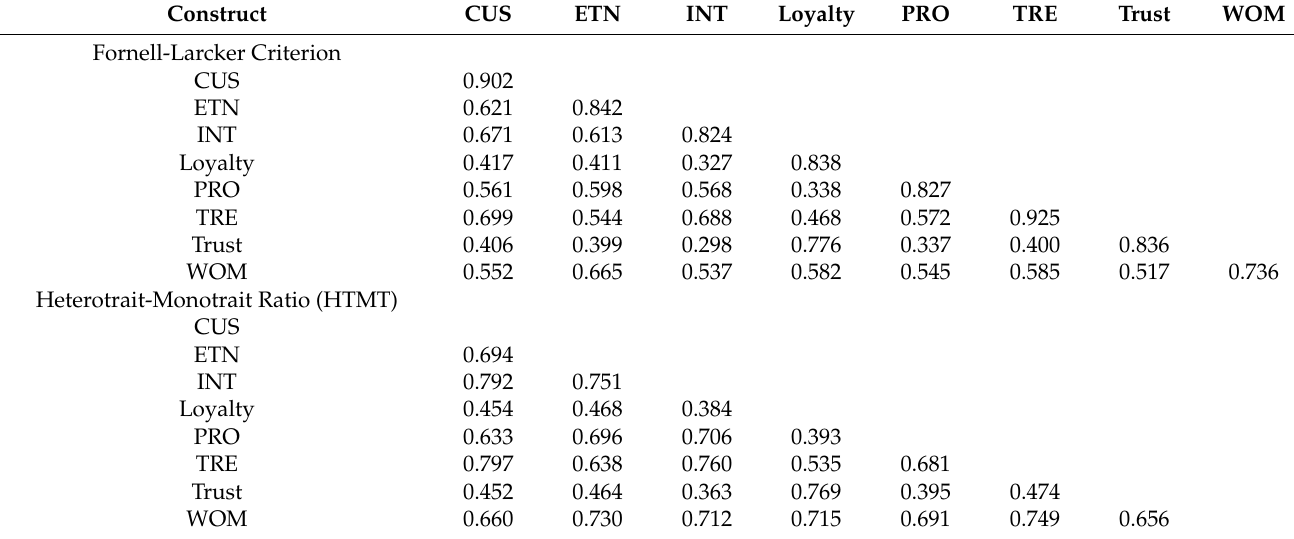
Table 3. Discriminant validity.